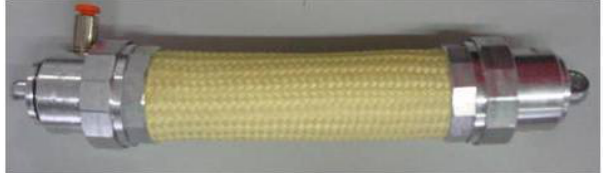
Figure 5. Prototype of a DIMEAS braided pneumatic